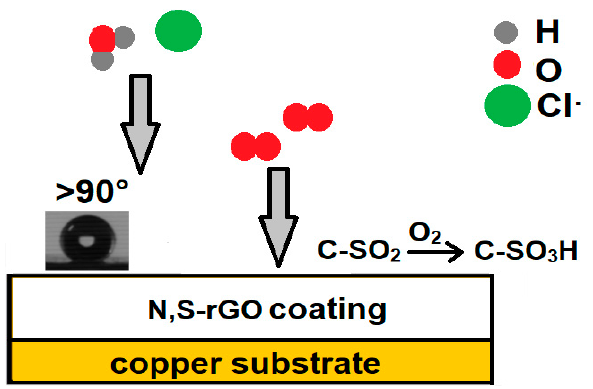
Figure 10. The protection mechanism of functionalized graphene coatings.